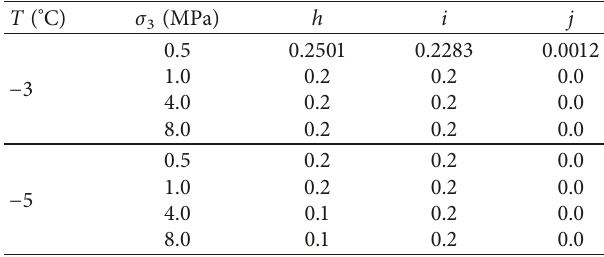
Table 1: Parameters related to the tangent modulus E